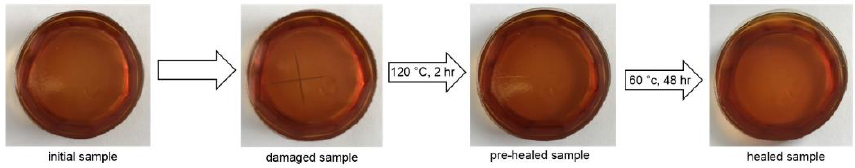
Figure 2. Self-healing properties of PU-DA sample demonstrated by two-stage thermal cycle. The resulting polymer PU-DA was also characterized by NMR and IR spectroscopy (for detailed NMR spectra, see Supporting information). Identification and comparative analysis of structure for prepolymer and remendable PU are given below.